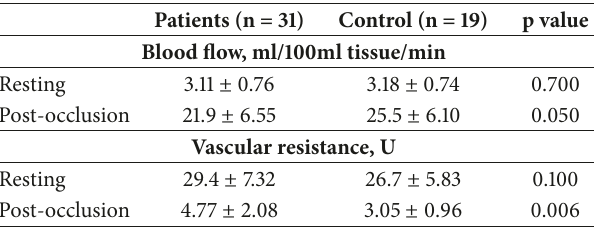
Table 2: Vascular function